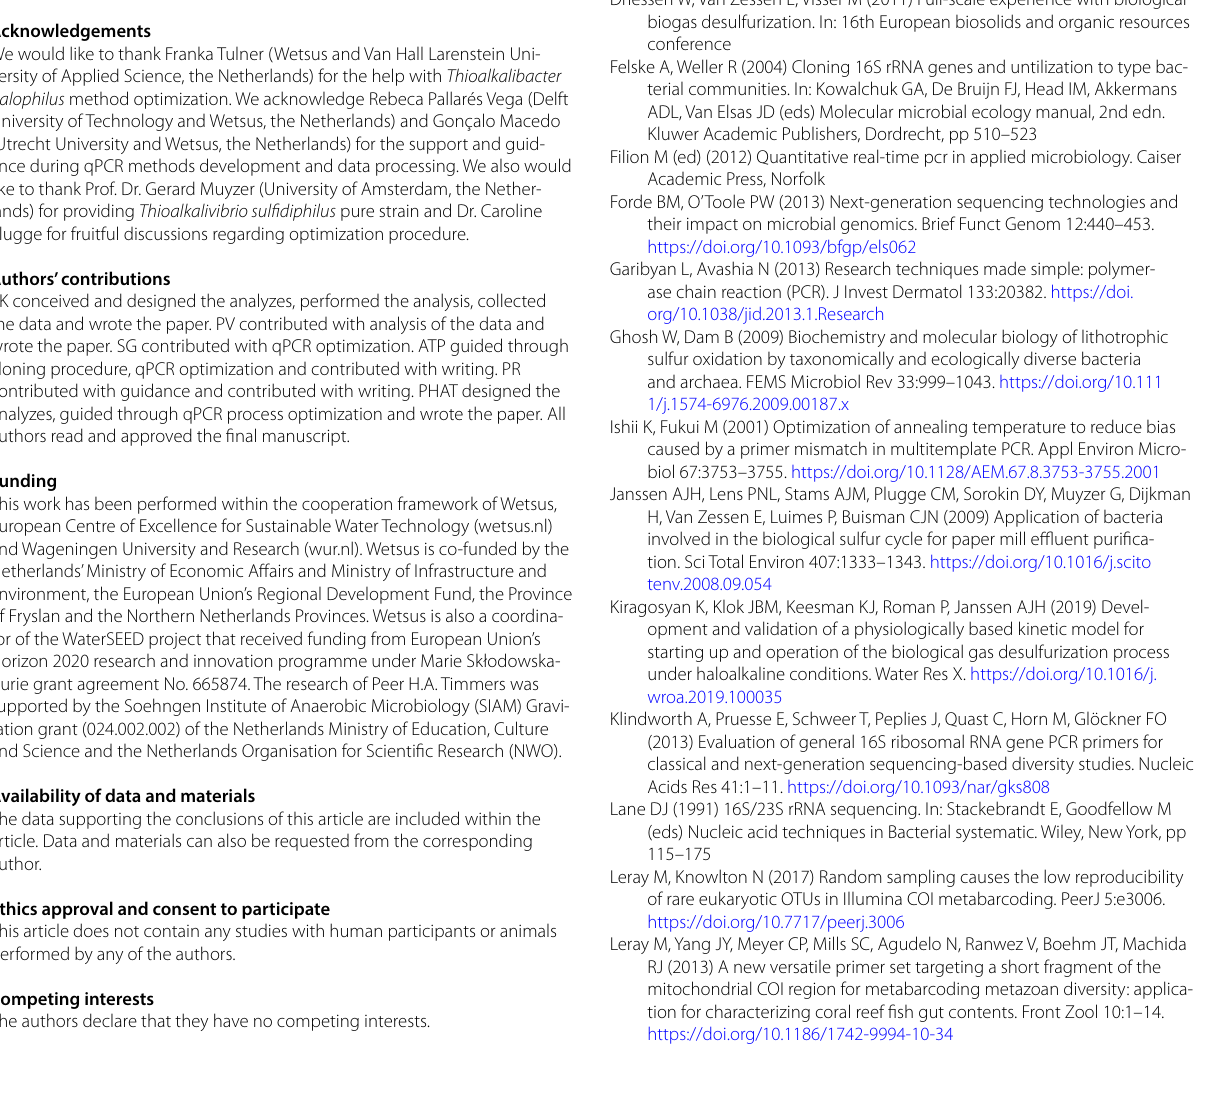
Additional file 1: Figure S1. Melting curve analysis of qPCR products of 16S rRNA gene of Thioalkalivibrio genus with use of SYBR Green. Figure S2. Melting curve analysis of qPCR products of 16S rRNA gene of Alkalilim- nicola ehrlichii with use of SYBR Green. Figure S3. Melting curve